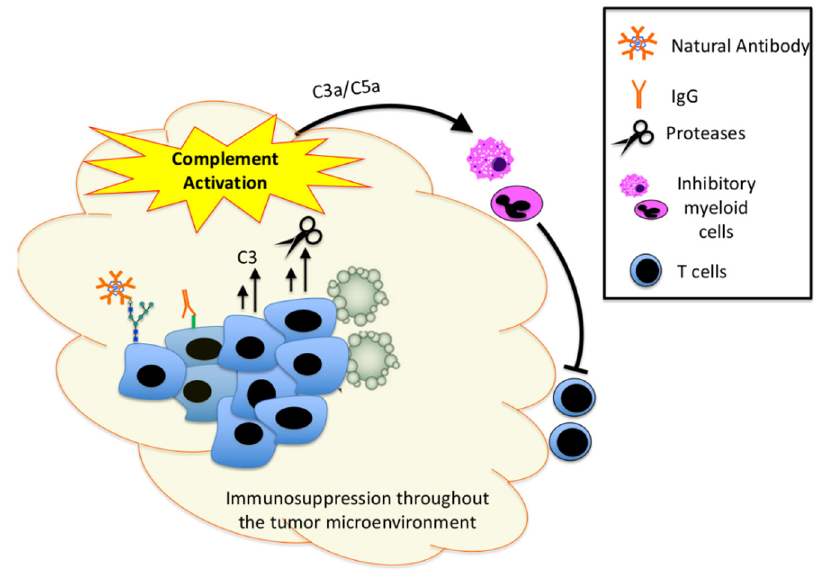
Figure 2. Mechanisms by which cancer cells activate complement to control the tumor microenvironment. Tumor cells actively promote complement activation by several mechanisms. The natural antibody binds to glycans on the cell surface, and IgG binds to tumor neoepitopes. Cancer cells also produced complement proteins, such as C3, which fuels local activation. Cancer cells can also release proteases, such as cathepsin L, which directly activate complement proteins. Complement activation within tumors likely causes apoptosis and necrosis of some target cells, but it also produces C3a and C5a which recruit inhibitory myeloid cells into the tumor microenvironment. These myeloid cells suppress the anti-tumor function of CD4 and CD8 T cells.